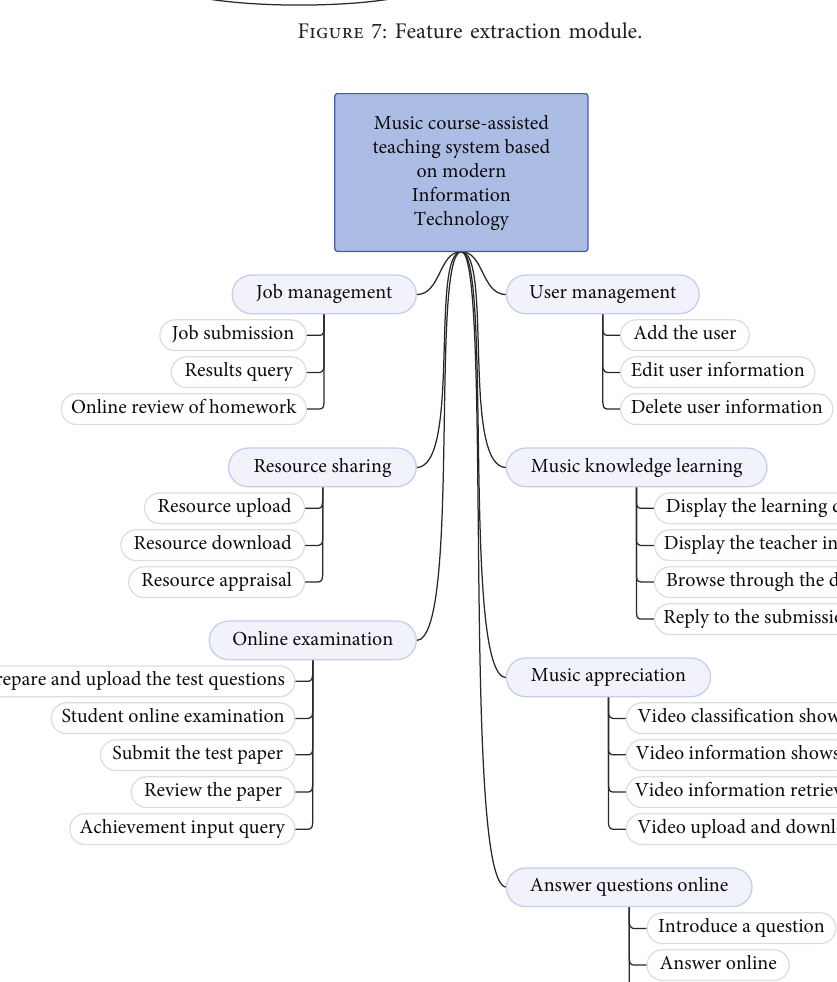
Figure 7: Feature extraction